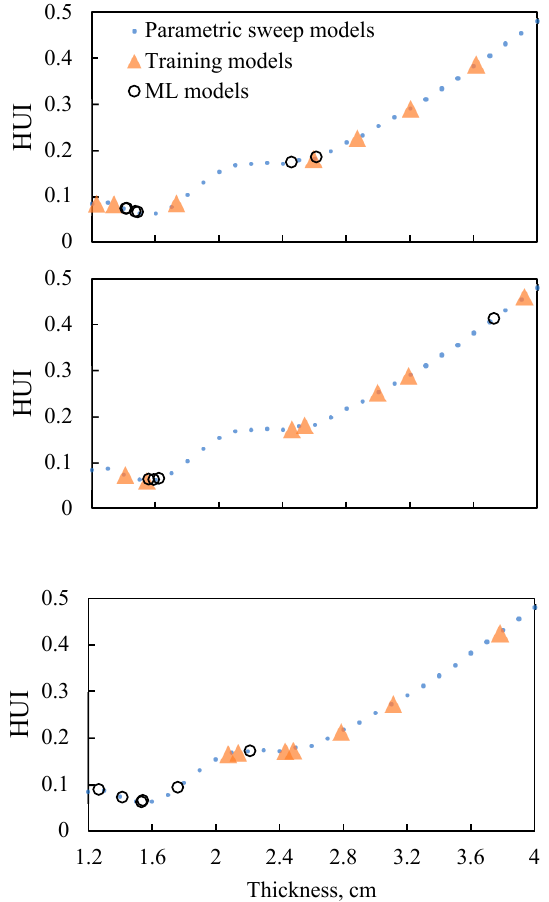
Figure 9. Triplicates of machine-learning optimization process with randomly selected training datasets for the rectangular frustum-shaped sample.